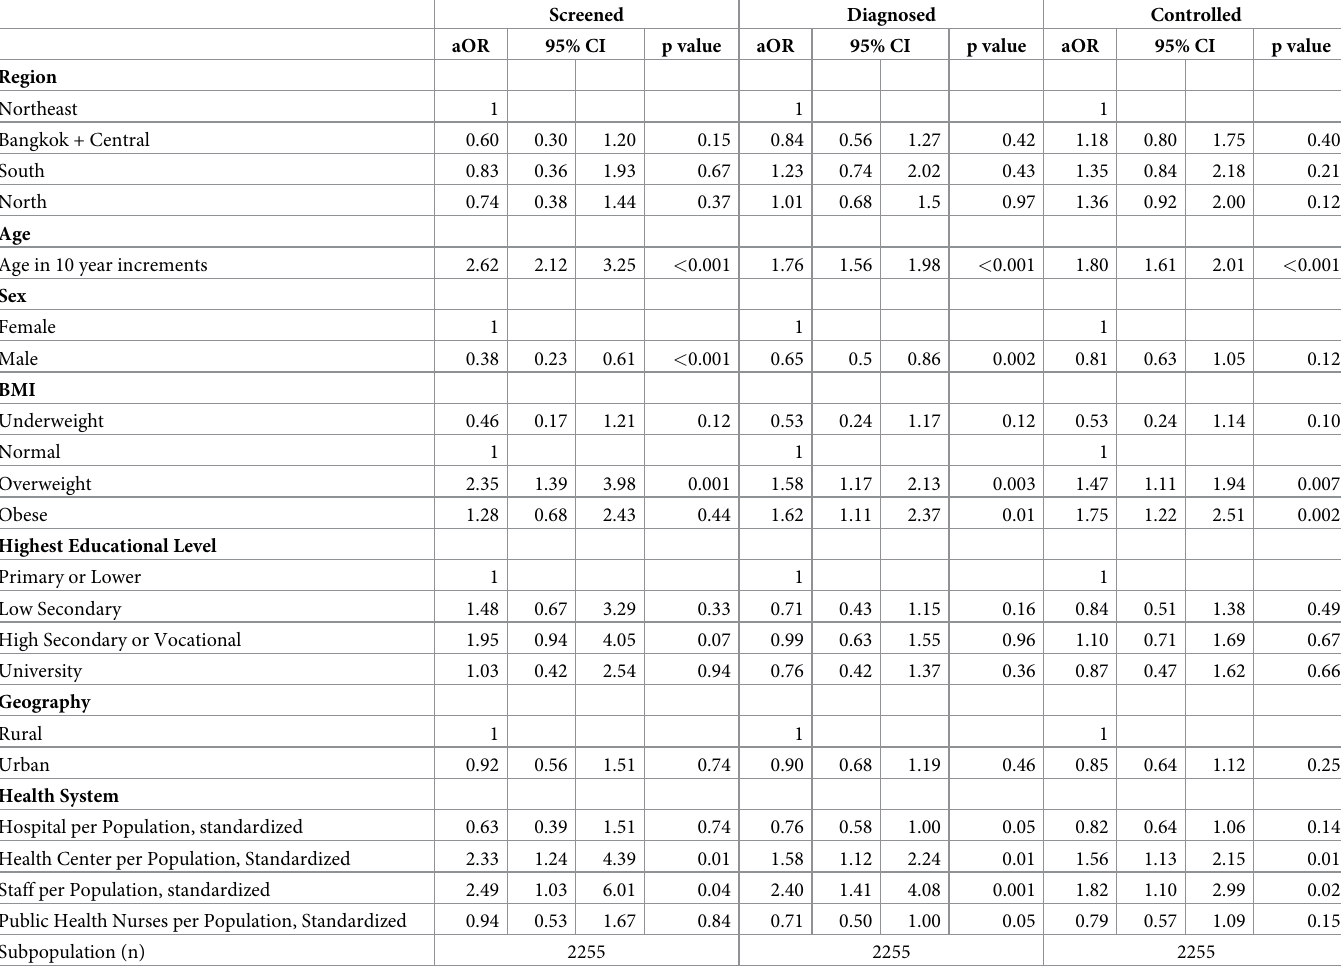
Table 2. Factors associated with diabetes care cascade retention, Thailand 2014. Un-nested logistic regression.